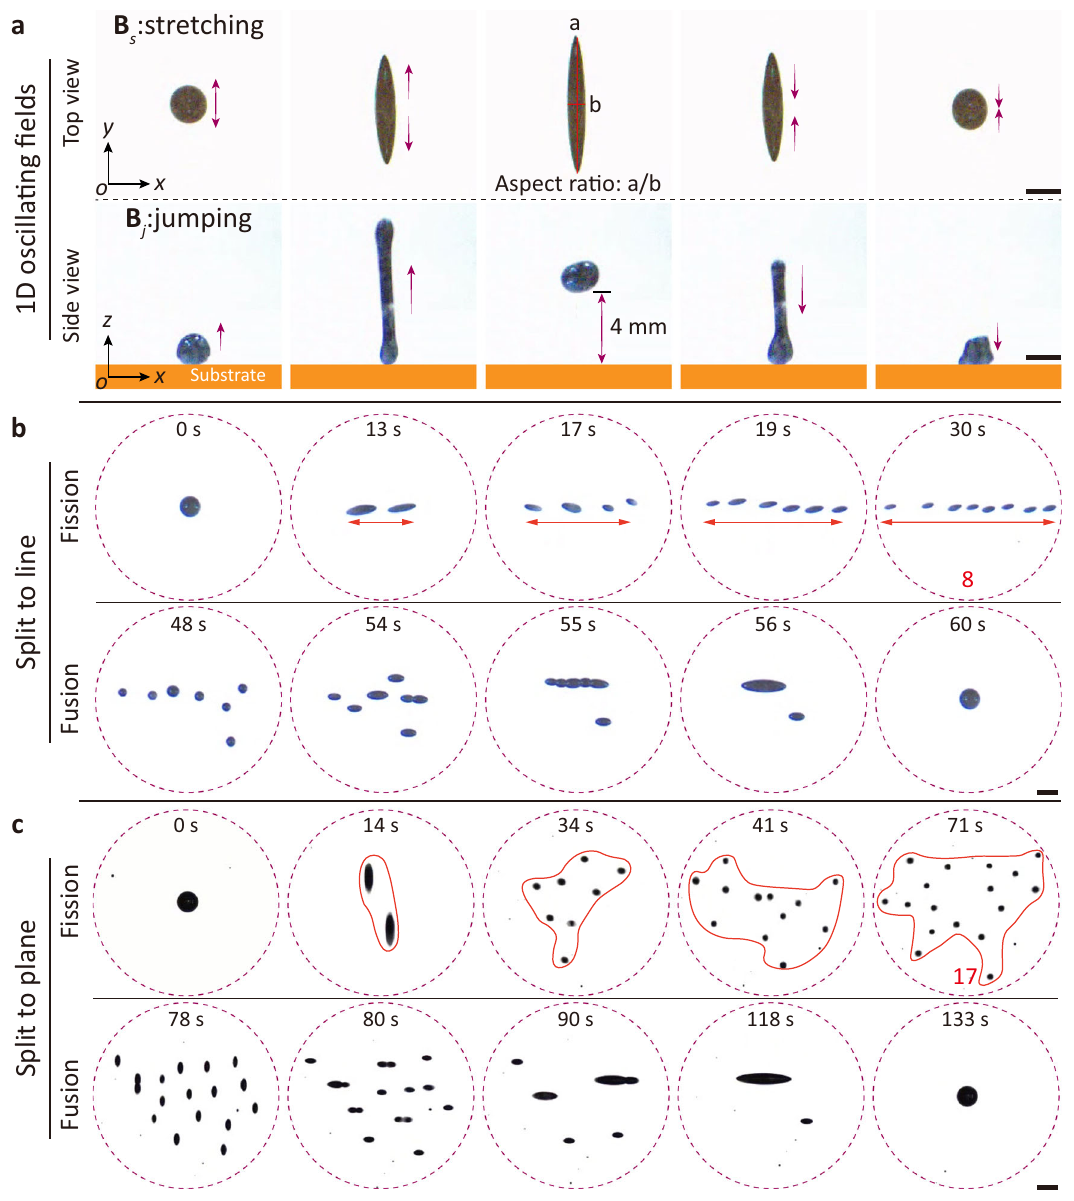
Fig. 3 | Fission and fusion scenarios. a Stretching and jumping. a and b represent the length and width, respectively. Ferro fl uid droplets exhibiting stretching and jumping postures under 1D oscillating fi elds B s ( t ) and B j ( t ), respectively. B s ( t ): frequency f = 1 Hz and magnitude B m = 9 mT. B j ( t ): f = 100 Hz and B m = 9 mT. b Under a 2D oscillating magnetic fi eld B Osc ( t ), one